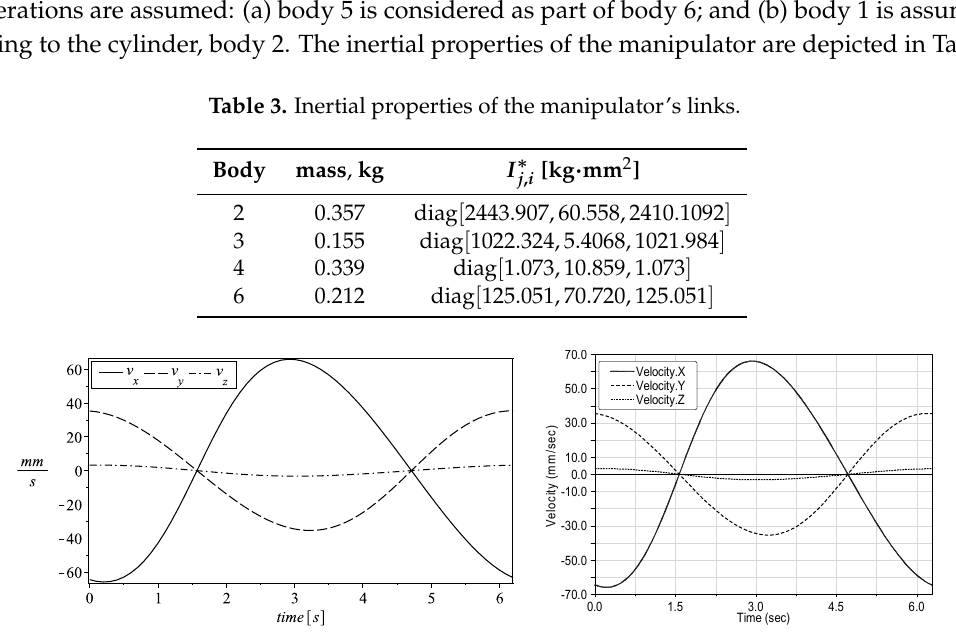
Figure 9. Velocity of point P . Using screw theory ( left ); and simulations in ADAMS/View 2014 ( right